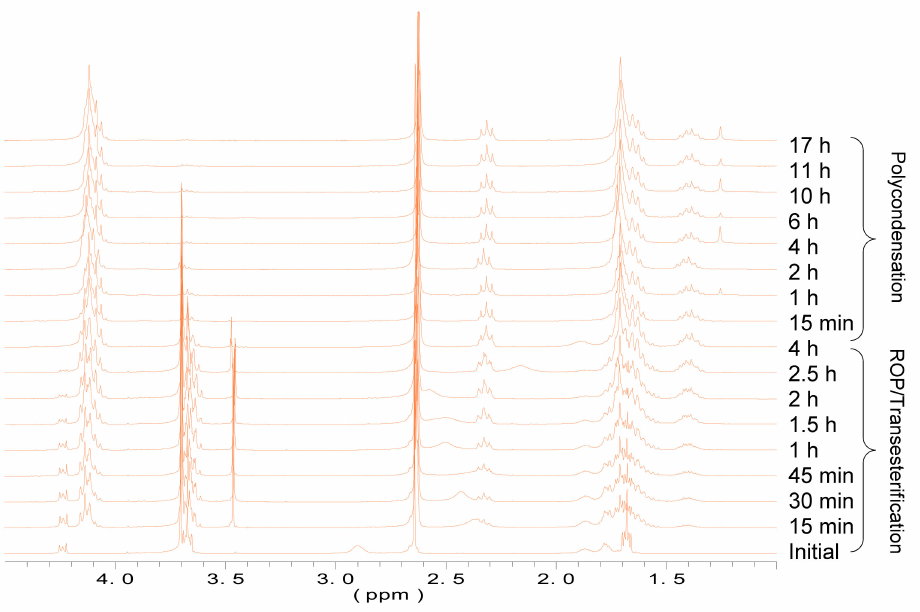
Figure 2. Evolution of 1 H-NMR spectra of PBS 70 CL 30 copolyester synthesis with reaction time. The initial sample was recorded without CALB